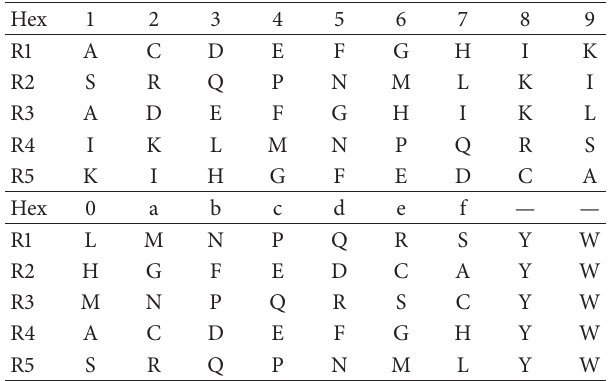
Table 1: Five different representations R1–R5 of malware hexadeci- mal signatures.